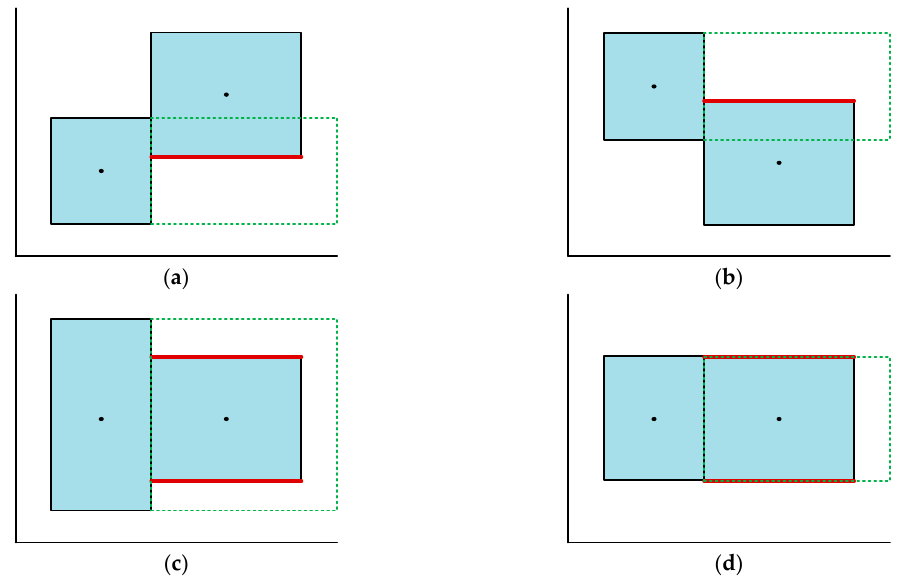
Figure 9 . Examples of adjacent cases. ( a ) Upper adjacent; ( b ) Lower adjacent; ( c ) Dual adjacent-1; ( d ) Dual adjacent-2.